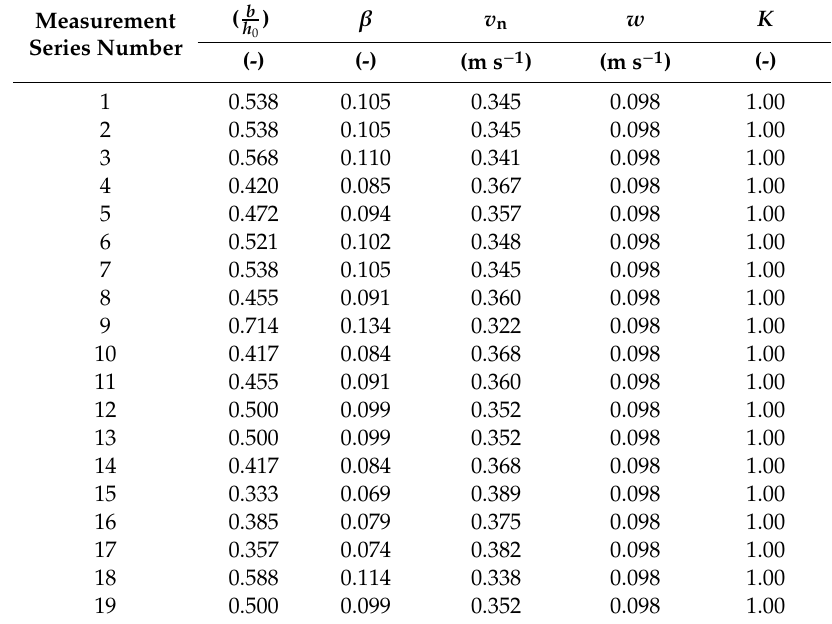
Table 2. Computational parameters of the Equation (1) Begam’s formula after D ˛abkowski et al. [5].